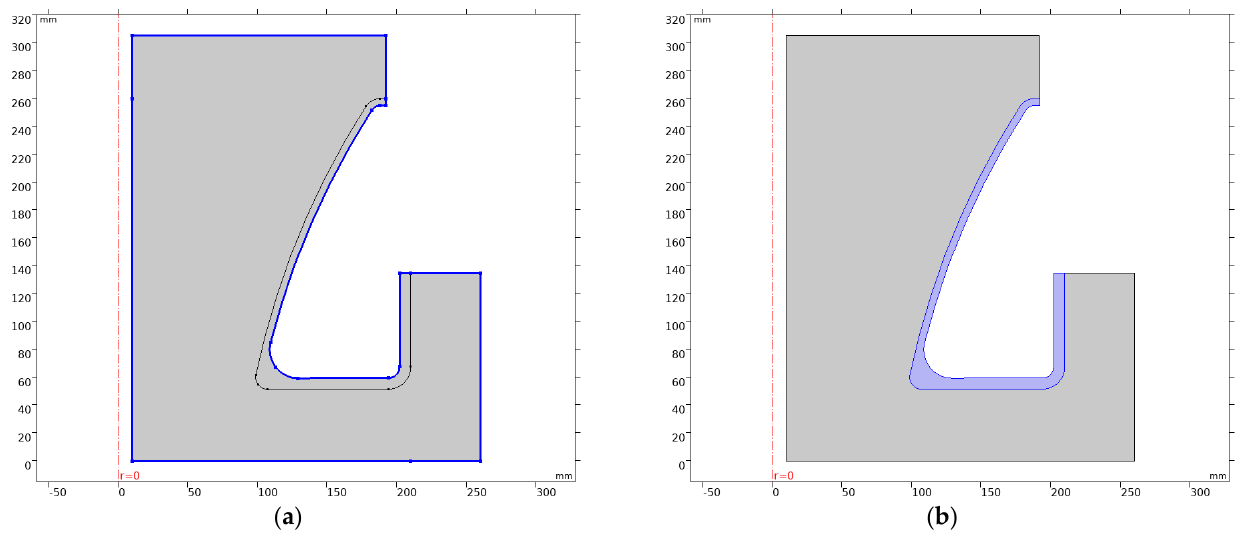
Figure 1. Boundary condition: ( a ) edge subject to heat flow; ( b ) additional heat source due to the kinetic polymerisation.